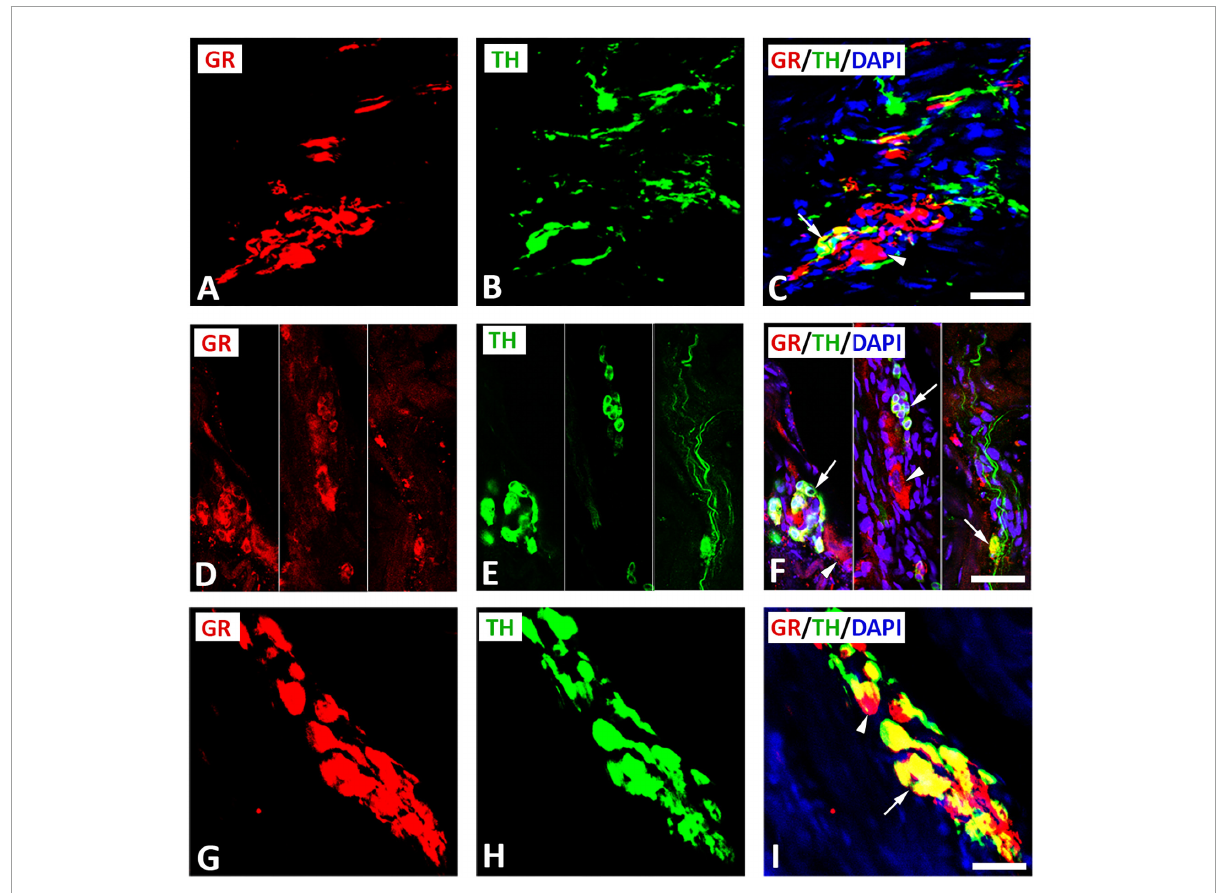
FIGURE4 Confocal microscopy of GR (A,D,G ) ( red fluorescence ) and sympathetic neuronal marker tyrosine hydoxylase (TH) (B,E,H) ( green fluorescence ) double immunofluorescence in intracardiac ganglia (A–I) . (A–C) Show GR co-expressed with TH ( yellow fluorescence ) in cluster of three small intensely fluorescent (SIF) cell (arrow), however, some neuronal soma express GR in large size principal cell (arrowhead) or TH only. (D–F) ( right and middle ) Show a cluster of TH-immunoreactive small intensely fluorescent (SIF) cells (arrow) co-express GR ( yellow fluorescence ) that were much smaller than the surrounding large size principal ganglion cells ( red fluorescence ) (arrowhead). (D–F) (Left) show unipolar small intensely fluorescent SIF cells expressing GR (arrow). (G–I) Show a cluster of small cells of cardiac ganglia coexpressing GR (arrow) and TH, however some cell express GR only (arrowhead). (C,F,I) Show DAPI nuclear staining ( bright blue ). Bar: (A–F) = 40 µ m; (G–I) = 80 µ